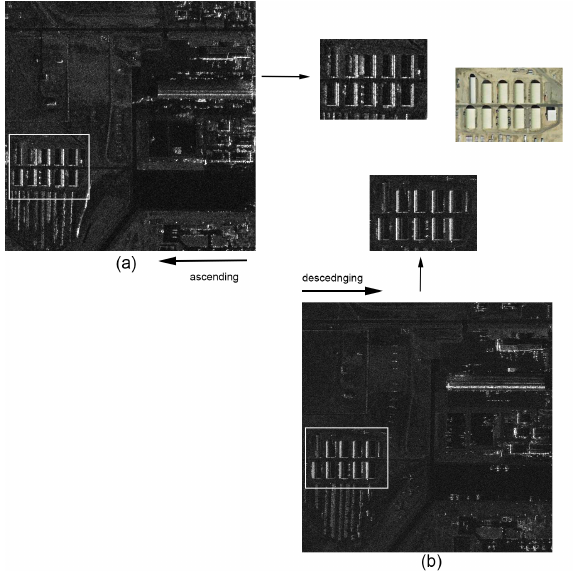
Figure 1. Two multiview SAR images of the same area and comparsions. (a) Ascending orbit. (b) Descending orbit.